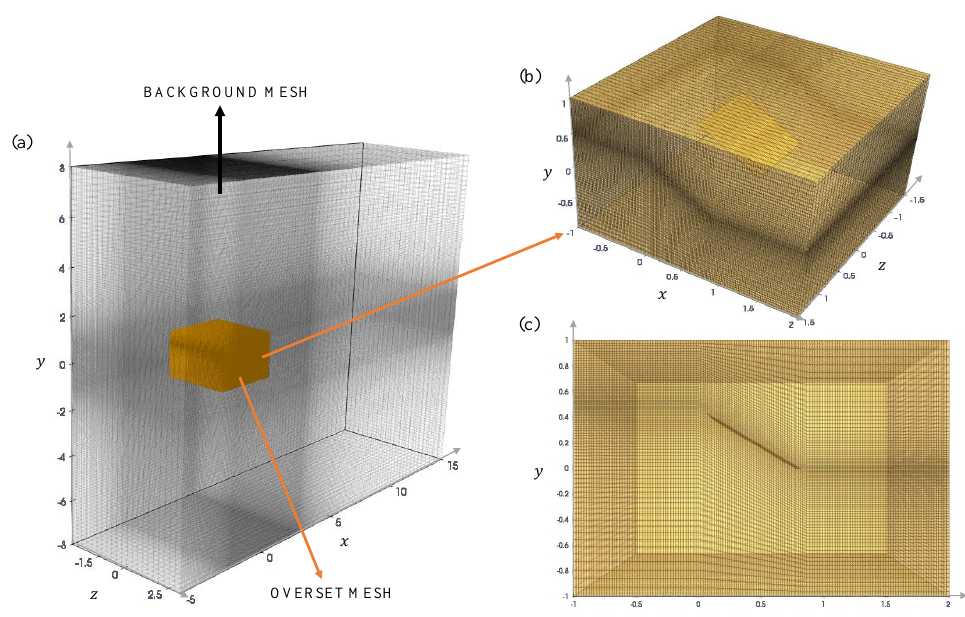
Figure 2. ( a ) Merged background and overset grid for stationary panel at α = 30 ◦ (Case 3). ( b ) shows the Isometric view for the secondary or “Overset” grid, while ( c ) represents the chordwise view of the overset grid.